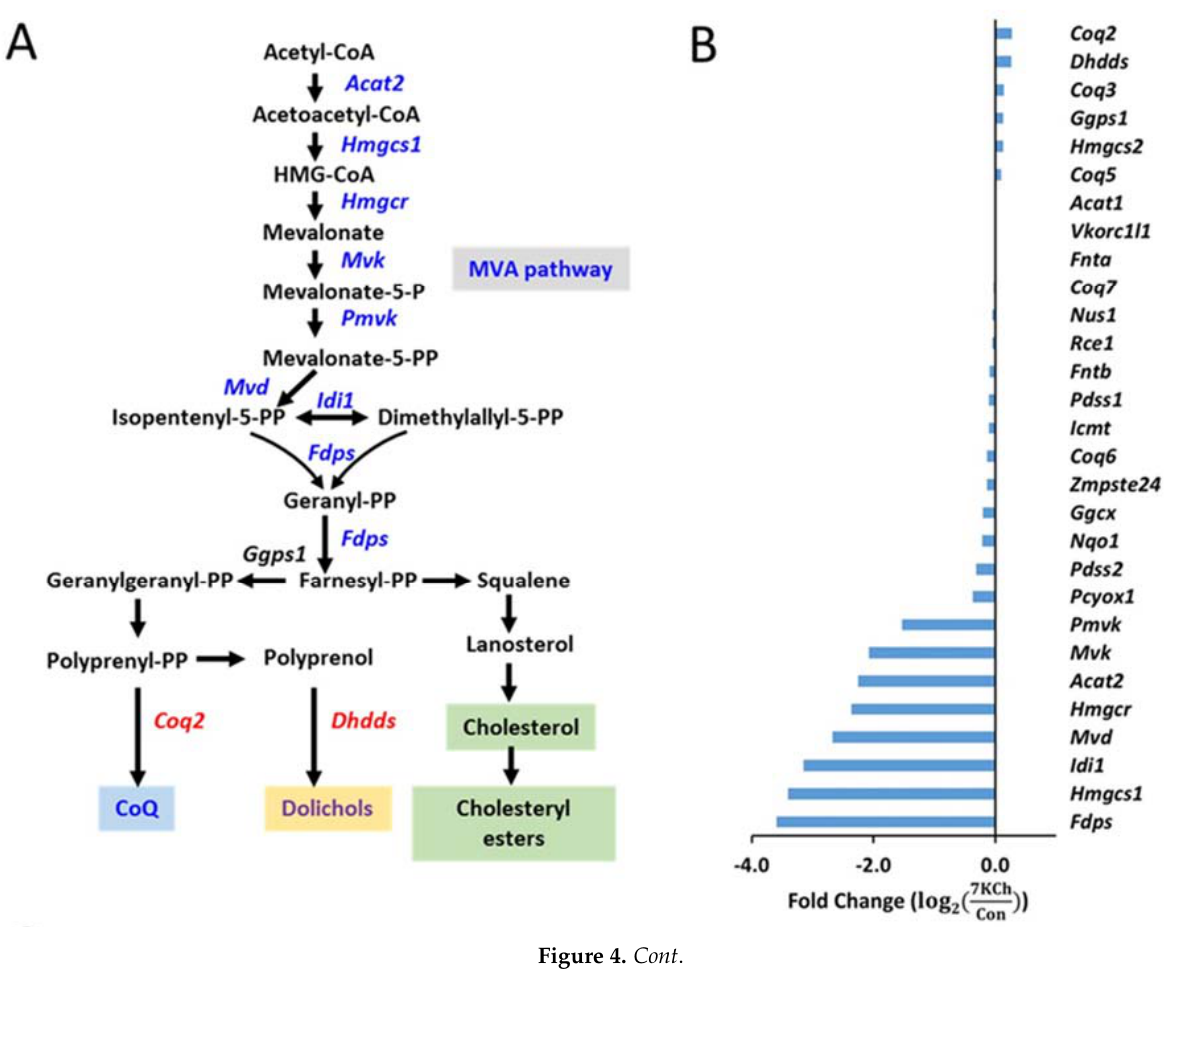
Figure 4. Effect of 7KCh on MVA pathway in cardiac cells. ( A ) A simplified diagram illustrating the mevalonate (MVA) pathway and its conversion to cholesterol, dolichol, coenzyme Q, and farnesyl ‐ PP and geranylgeranyl ‐ PP. Genes marked in blue represent the downregulated genes after 7KCh treatment, while those marked in red represent the upregulated